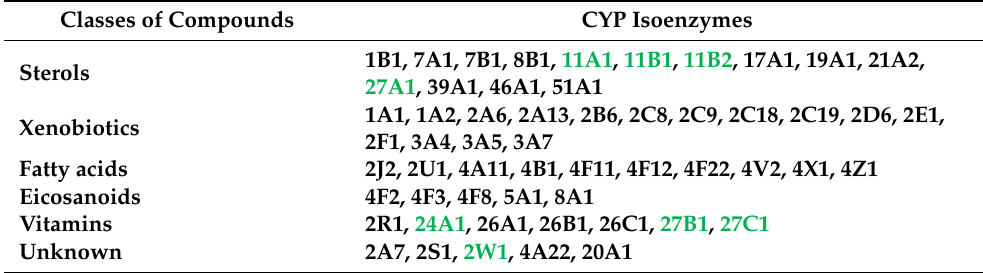
Table 1. Main classes of compounds metabolized by CYPs and major isoenzymes involved their